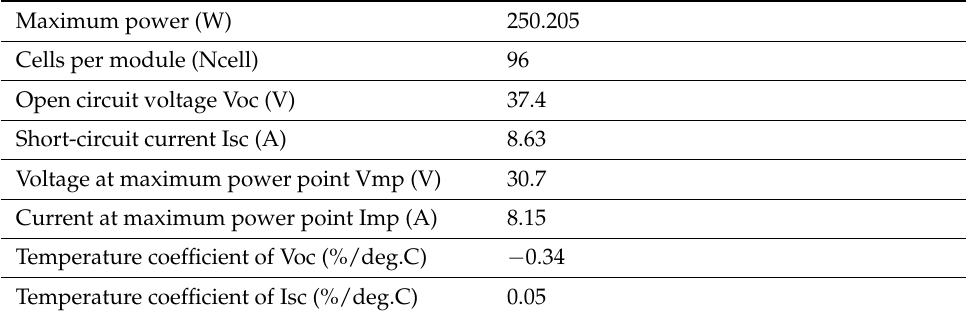
Table 2. Main parameters of PV